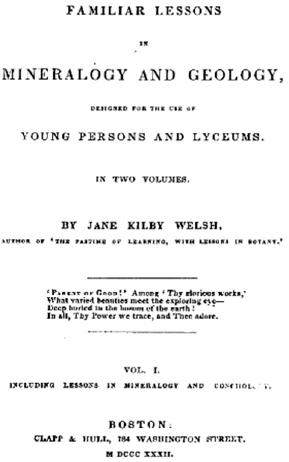
Figure 6. Welsh’s Familiar Lessons in Mineralogy and Geology [30].